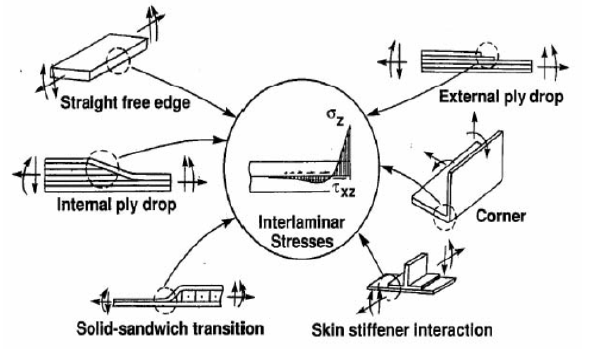
Figure 5. Different types of Delamination (Source: (Avadutala, 2005)